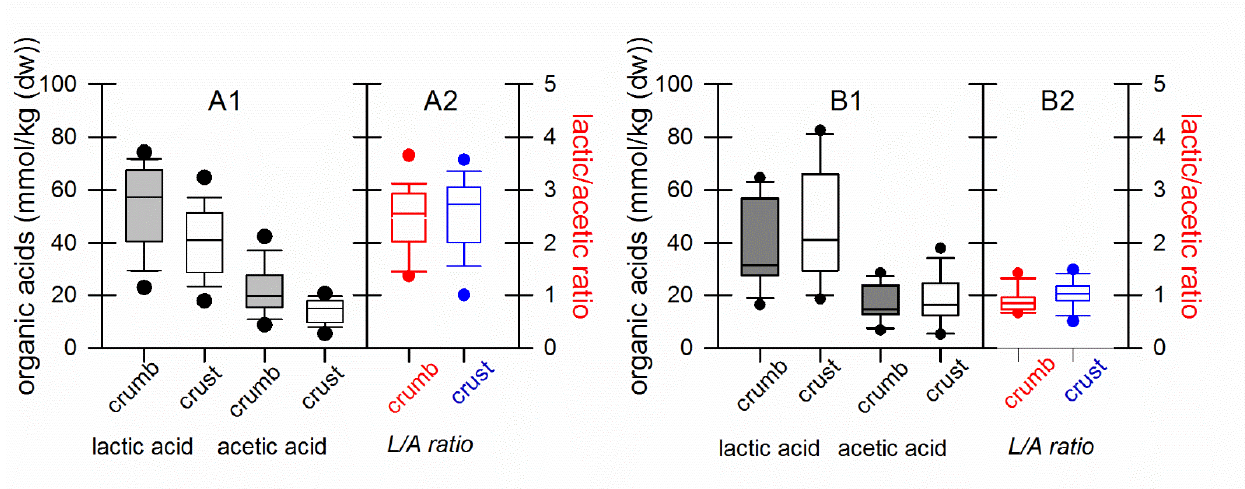
Figure 6. Lactic acid and acetic acid content, and lactic/acetic acid ratios in the crumb and the crust of sourdough of artisanal ( n = 19) and supermarket ( n = 13) bought loaves. The data are represented in box plots, with the box representing the central 50% of the data ranges and the whiskers representing the upper and lower 25% quartiles of the data ranges. The dots ( • ) represent the extent of the outlying data. ( A1 ) Organic acid content in artisanal sourdough breads. The grey boxes represent the data from the crumb, whereas the white boxes represent the data from the crust. ( A2 ) Lactic/acetic ratios in artisanal sourdough breads. The red boxes represent data from the crumb, blue boxes represent data from the crust. ( B1 ), organic acid content in supermarket bought sourdough breads. The grey boxes represent the data from the crumb, while the white boxes represent the data from the crust. ( B2 ) Lactic/acetic ratios in supermarket bought sourdough breads. The red boxes represent data from the crumb, and blue boxes represent data from the crust.